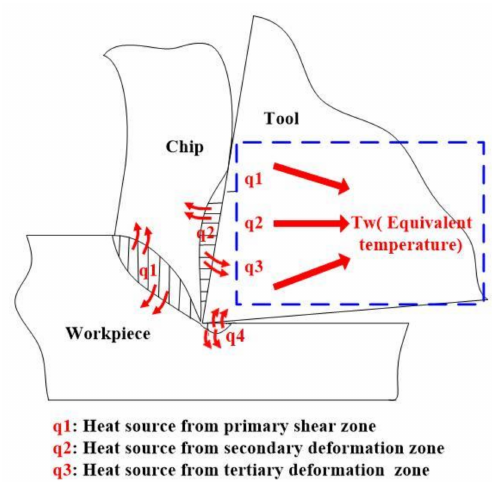
Figure 1. Heat source and equivalent heating temperature of the cutting